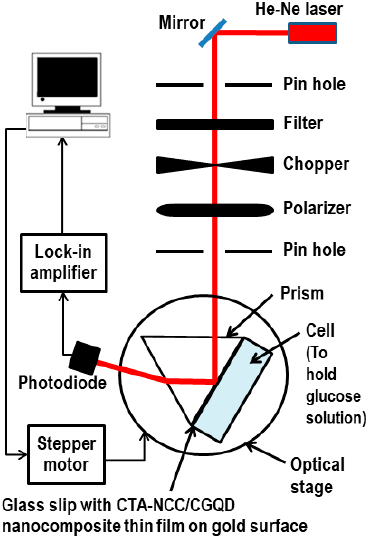
Figure 2. Experimental setup of surface plasmon resonance (SPR) sensor.